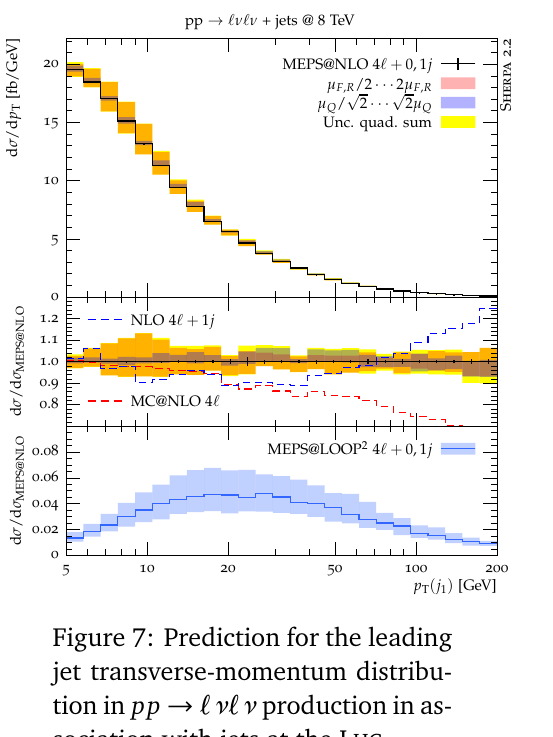
Figure 7: Prediction for the leading jet transverse-momentum distribu- tion in pp → (cid:96)ν(cid:96)ν production in as- sociation with jets at the L HC .